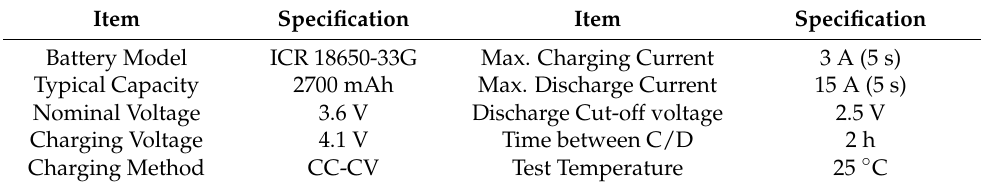
Table 5. Initialization of tested cells.